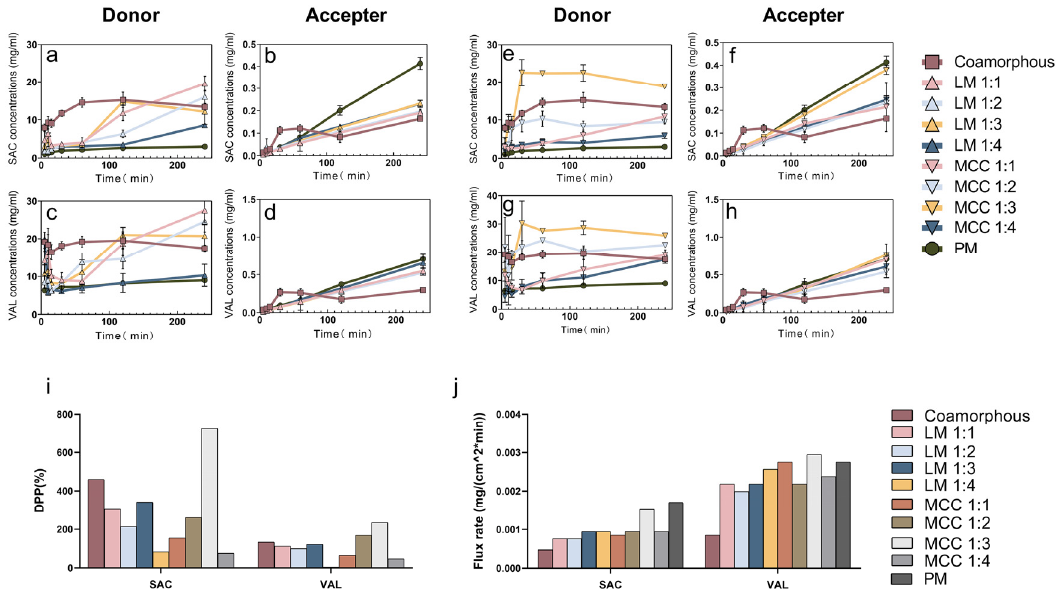
Figure 6. The dissolution and permeation properties of physical mixture (PM), co-amorphous SDs, ( a – d ) co-amorphous LM SDs and ( e – h ) co-amorphous MCC SDs in PBS ( n = 3). (i) DPP comparison of co-amorphous SDs and co-amorphous inert carriers SDs. ( j ) The flux rate of physical mixture (PM), and spray-dried preparations.